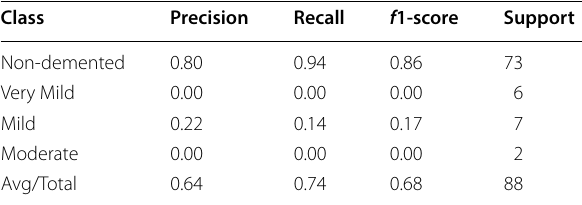
Table 5 Classification performance of M 5 model